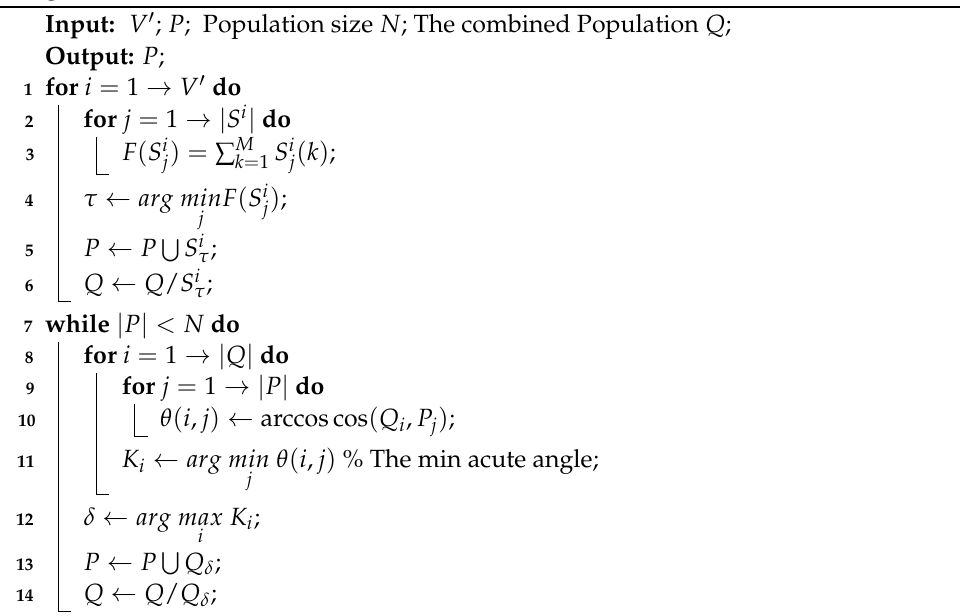
Algorithm 5: Environmental